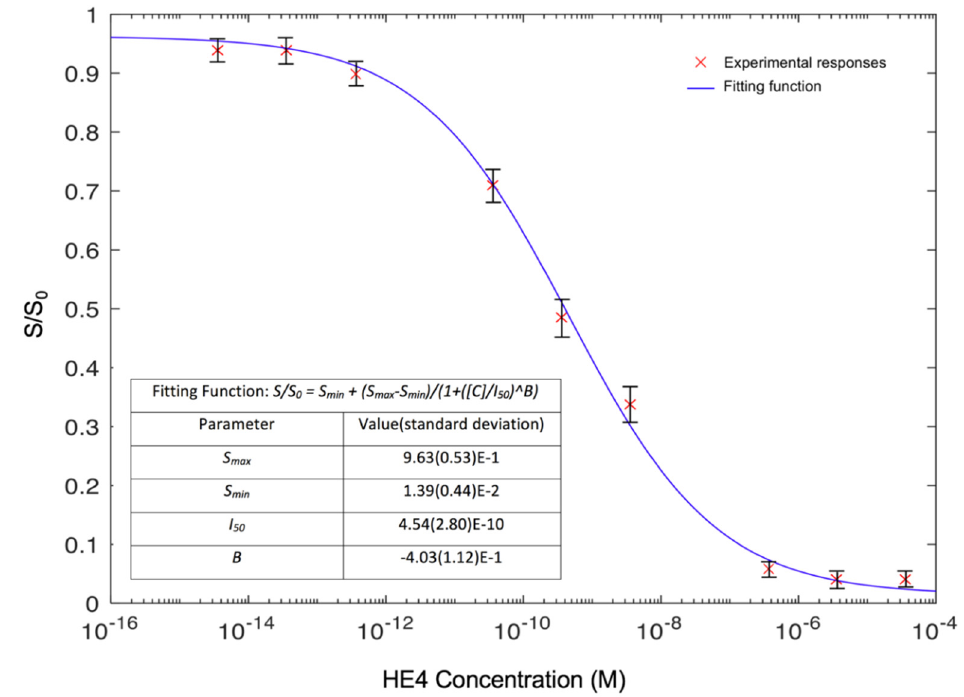
Figure 4. Dose-response inhibition curve for HE4-spiked human serum samples obtained interpolating the dataset from immunocompetition experiments carried out on HE4-modified MBs over the 3.5 fM–35 µ M concentration range while using the four-parameter logistic function (1). Inset table: fitted curve parameters.